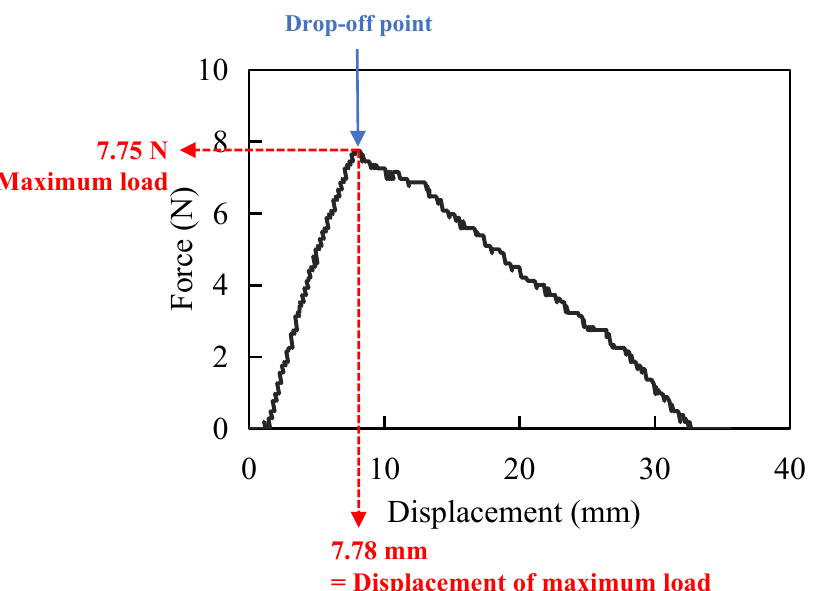
(Figure 3, gray bars; Table 1). The hardness of the PDMS 10:1 specimen was too high, and the average maximum load was significantly higher than porcine tissue ( p < 0.001), which could not simulate the soft tissue. To adjust the hardness of PDMS, the base and curing reagent ratio was changed to 30:1. The average maximum load of PDMS 30:1 was 3.65 ± 0.214 N (Figure 3, black bars; Table 1), which is close to the porcine group ( p = 0.14, not significant), and this could be used for further pull-out experiments.